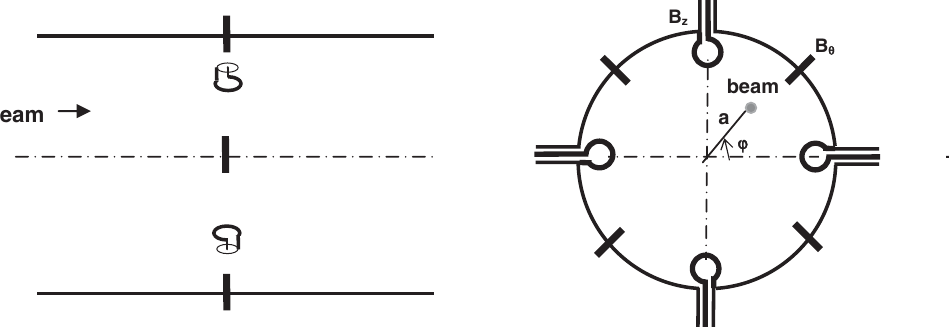
FIG. 4. Azimuthal B dots and axial B dots are composed to measure beam current, displacement, and beam deflection